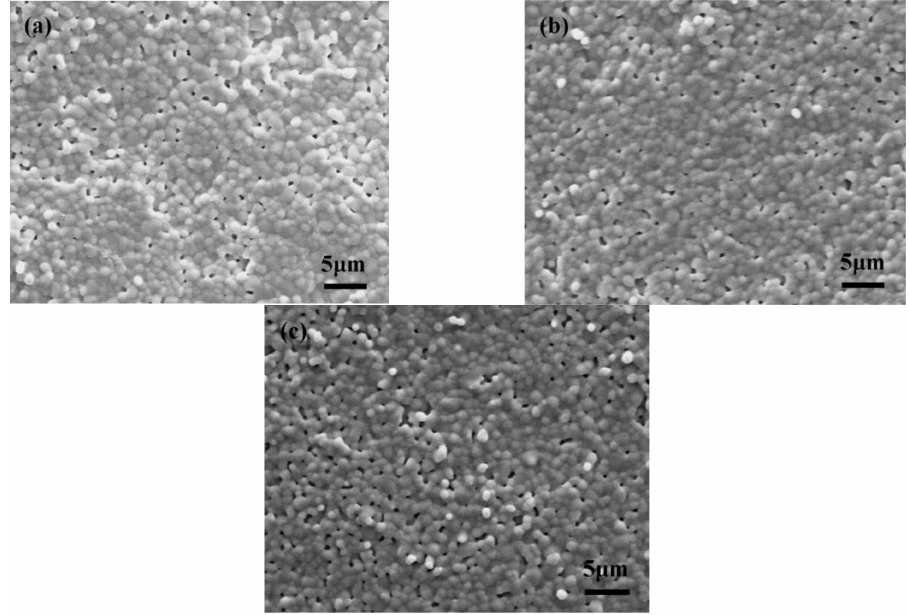
Figure 5. Thermally etched surface morphologies of (Y 1 − x Yb x )AG ceramic samples sintered at 1600 ◦ C, ( a ) x = 0, ( b ) x = 0.01, ( c ) x =